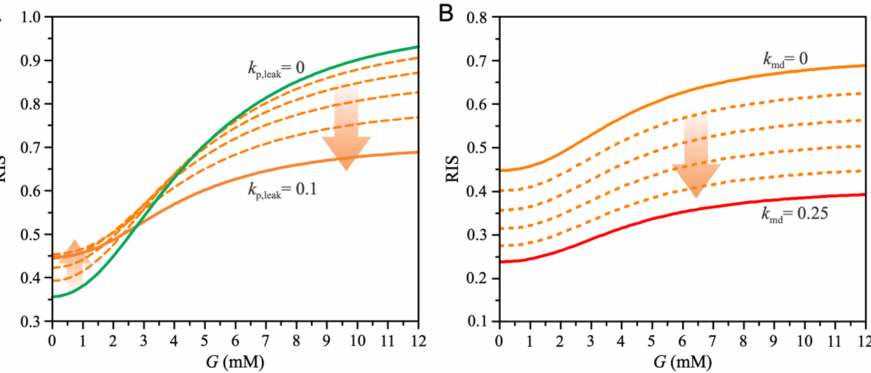
Figure 5. Effects of chronic lipid exposure on relative insulin secretion (RIS). ( A ) Effects of proton leak on glucose-dependent RIS. Increased proton leak flattens the glucose-dependent RIS curve, increases RIS at low glucose concentrations, and decreases RIS at high glucose concentrations. The value of parameter k p,leak increases from 0 to 0.1 with a step size of 0.02. ( B ) The effects of mitochondrial dysfunction on glucose-dependent RIS. Increased mitochondrial dysfunction reduces RIS at all glucose concentrations. The value of parameter k md increases from 0 to 0.25 with a step size of 0.05.